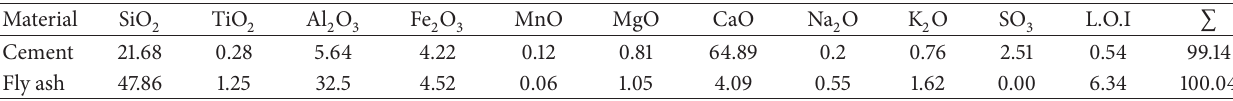
Table 1: The chemical composition of raw materials, wt.%.